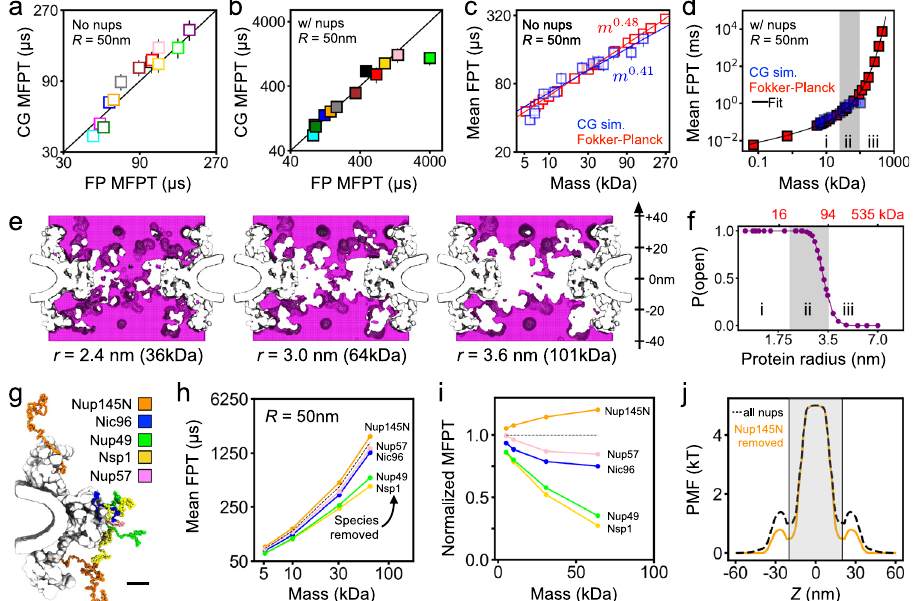
Fig. 5 | Fokker-Planck model of passive diffusion and the percolation transi- tion. a, b Comparison of the mean fi rst-passage times (MFPT) calculated from CG simulations to those from our Fokker-Planck void analysis model for the Lin2016 structure without FG-nups ( a ) and with FG-nups present ( b ). The black line indicates perfect agreement. Data in a, b presented as mean values ±SEM, based on traces involving N =140,000 frames. c MFPT from CG simulations (blue) and using our Fokker-Planck approach (red) as a function of protein molecular mass. Note the logarithmic scale of the axes. Power law fi ts, and their slopes, speci fi ed in the fi gure. d Same as in panel c but for the Lin2016 structure with FG-nups present. The black line shows a single fi t to all of Fokker-Planck data, see text for the functional form. The three regions (i, ii, iii) correspond to power law, transition and exponential scaling behavior. e Connectivity map of aninstantaneousNPCcon fi gurationcomputedforthreedifferentproteinprobe radii (speci fi ed under each map). Each map generated for ∣ z ∣ <40nm.